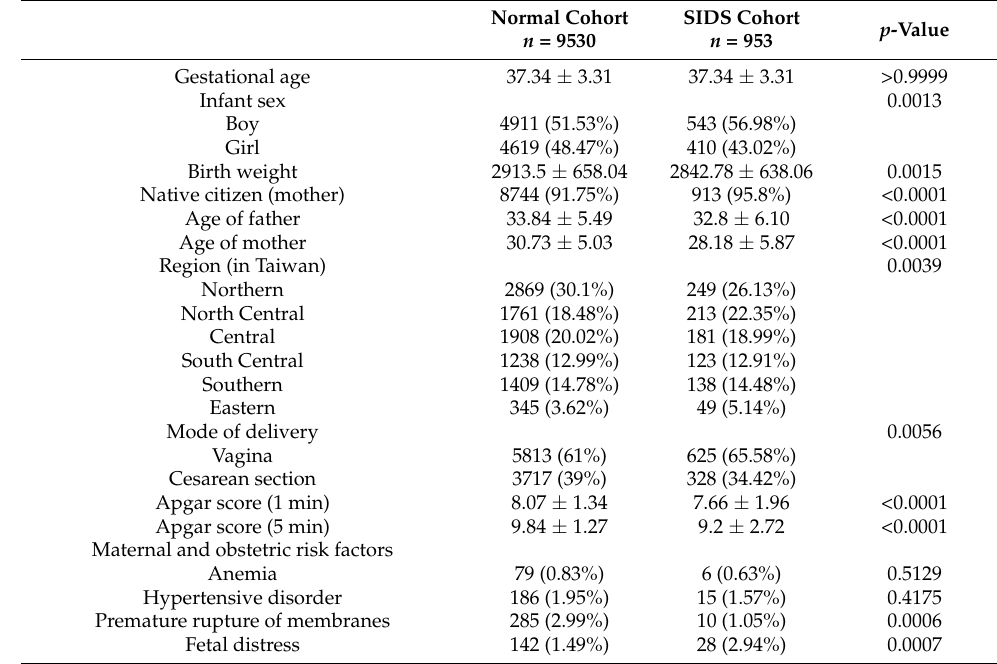
Table 1. Baseline characteristics of the study population coded with SIDS, Taiwan, 2004–2017.